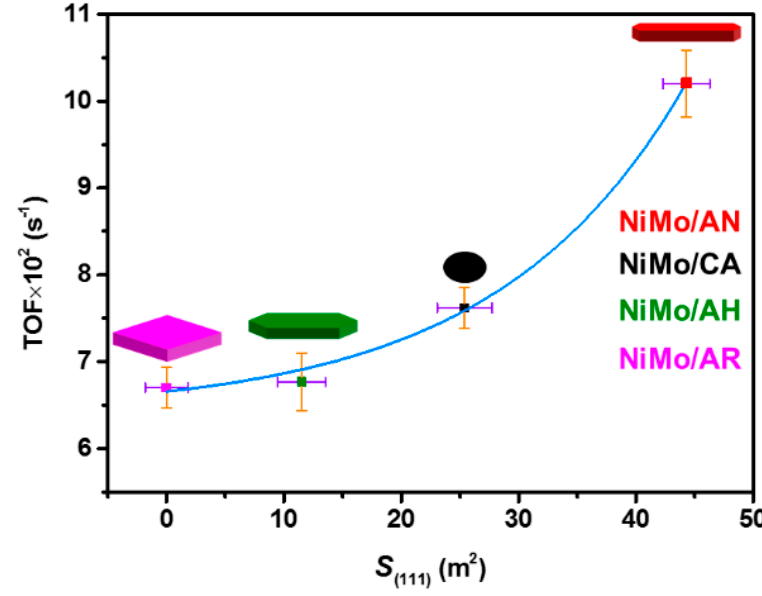
Figure 8. Average turnover frequency (TOF, s − 1 ) of thiophene HDS activity over sulfided NiMo / Al 2 O 3 catalysts as a function of an increased portion of (111) facets.